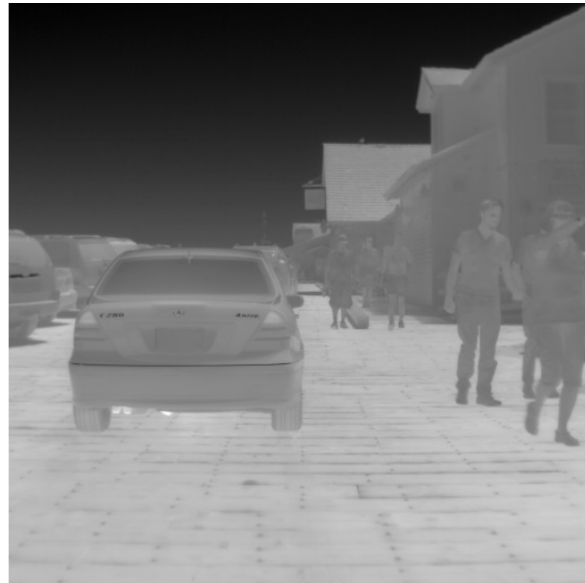
Figure 2. Raw grayscale thermal image at original resolution Another element common to all pansharpening algorithms is the necessary panchromatic image (PAN). This image must come from a higher resolution sensor. Usually, thermal cam- eras, mount a RGB visible spectrum sensor next to the thermal sensor, which helps to frame correctly the scene, as thermal im- ages sometimes lack contrast. This visible spectrum sensor has much higher resolution so it will provide us with our PAN pan- chromatic image, expressing the RGB image in